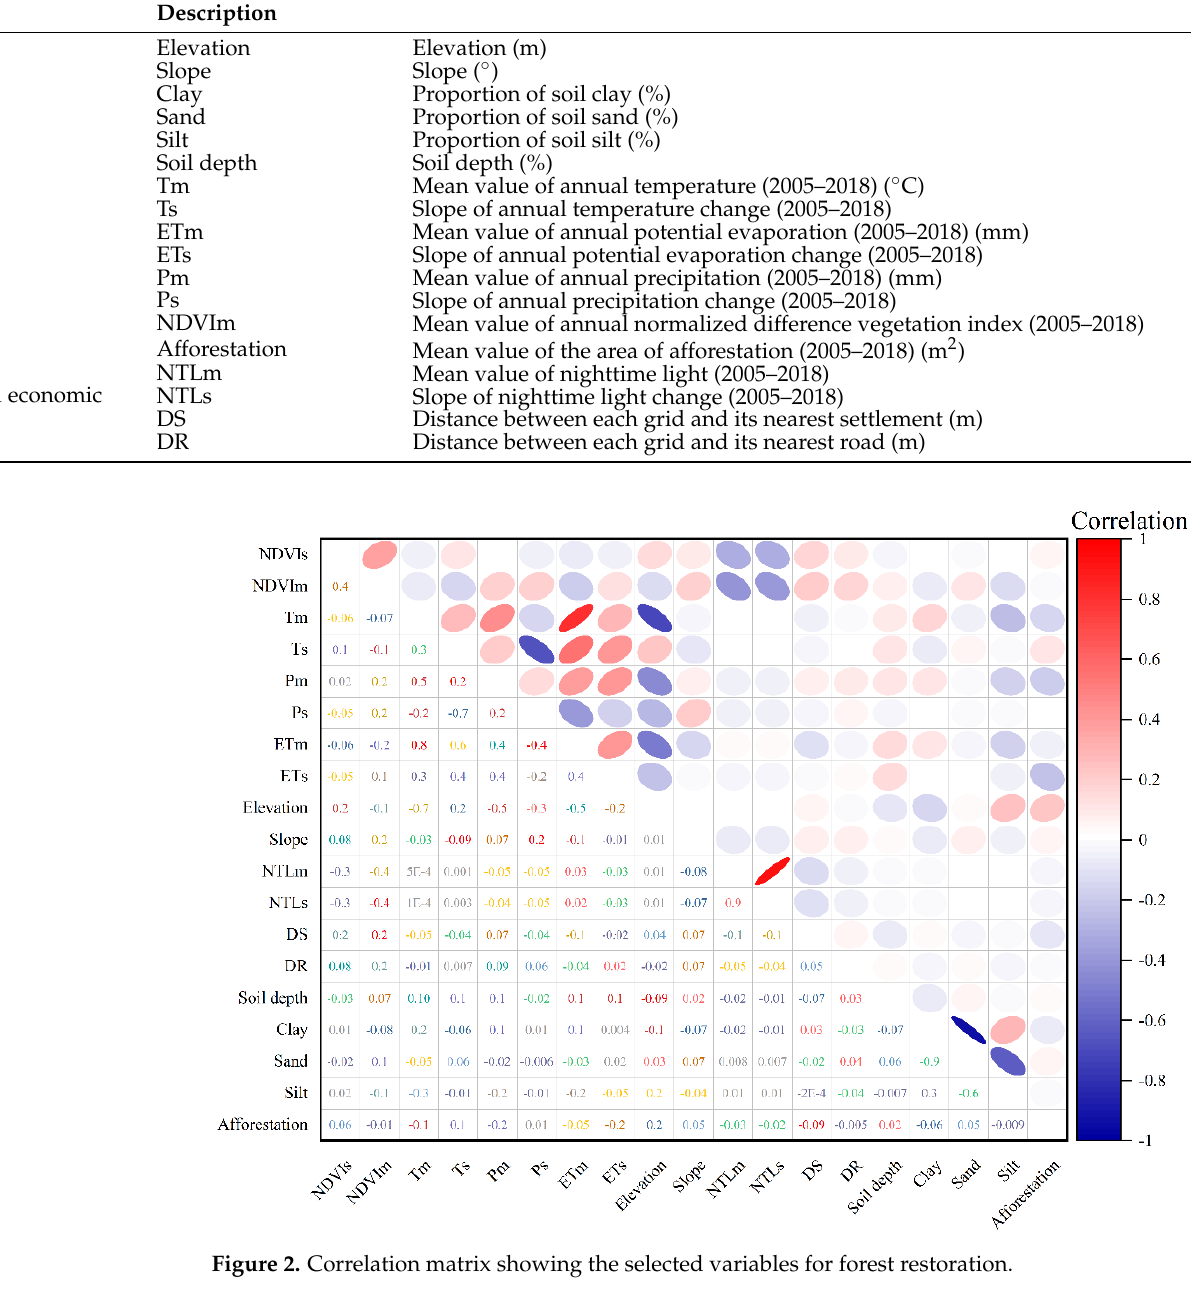
Table 1. Potential factors associated with grassland degradation.